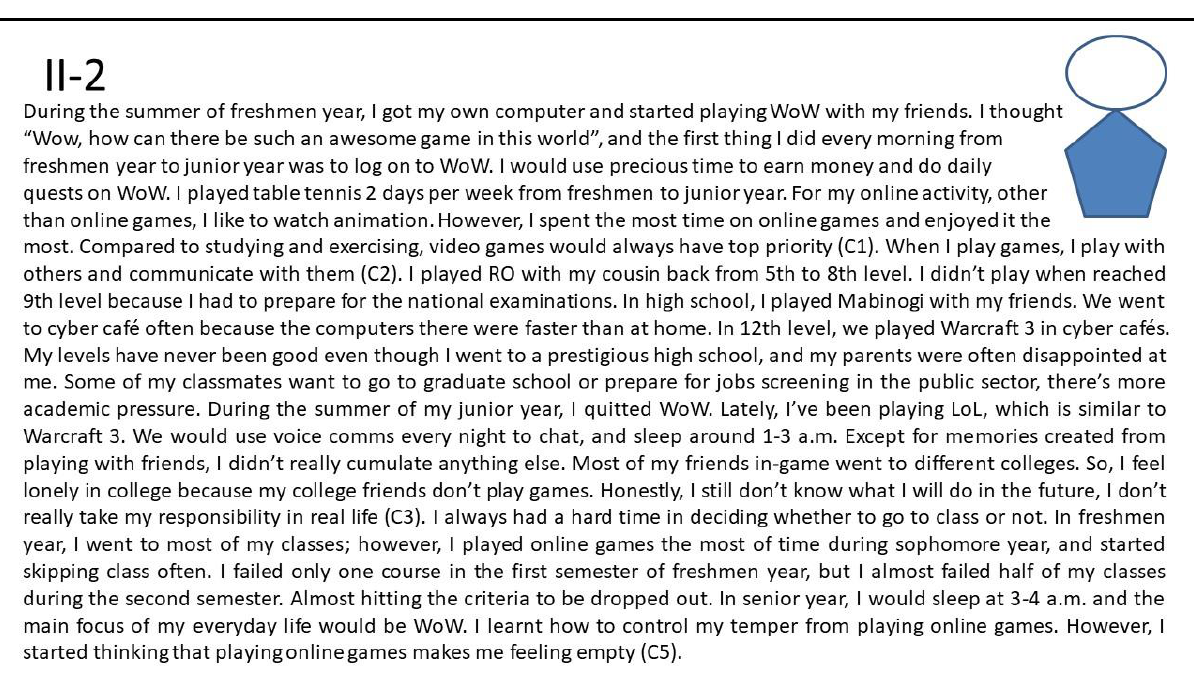
Figure 4. The person narrative about the fourth persona (II-2).